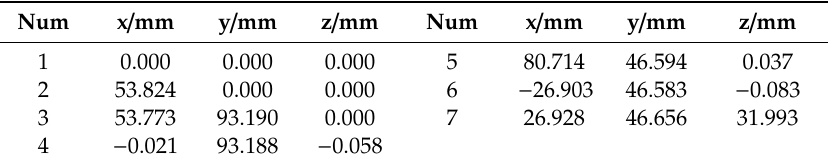
Table 1. Coordinates of receivers and retroreflector in TCS.